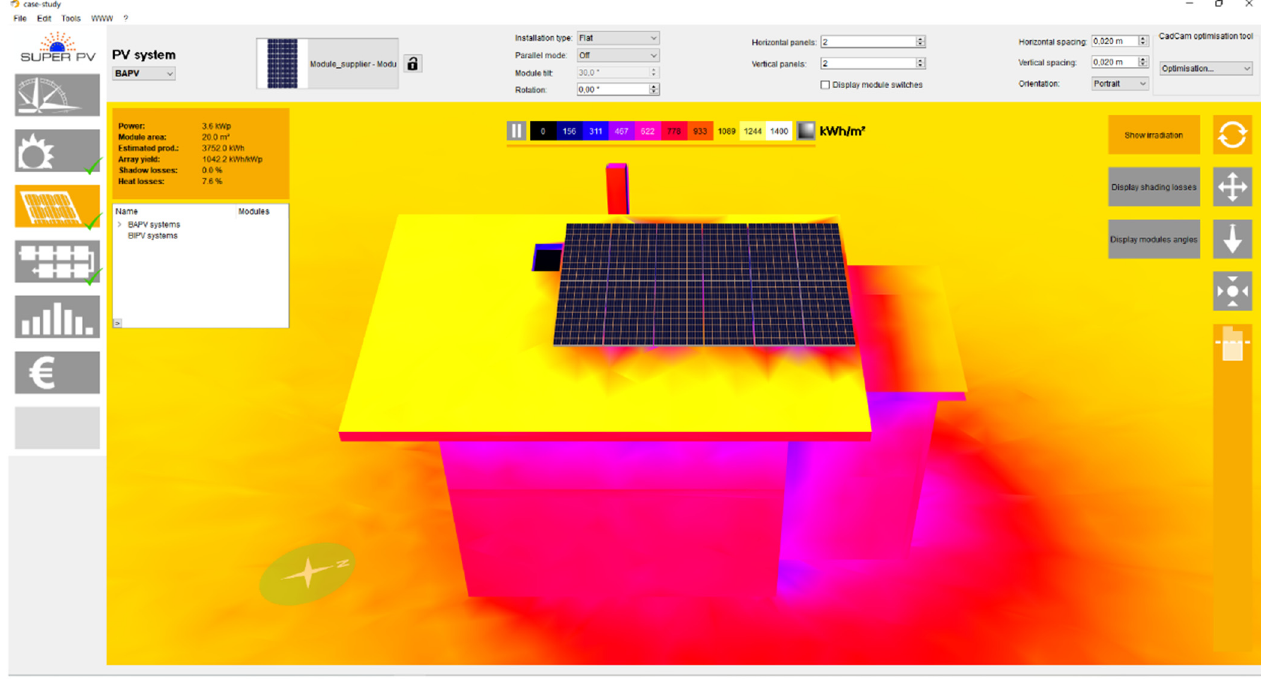
Fig. 9. PV case study in the SuperPV software for design and simulation.